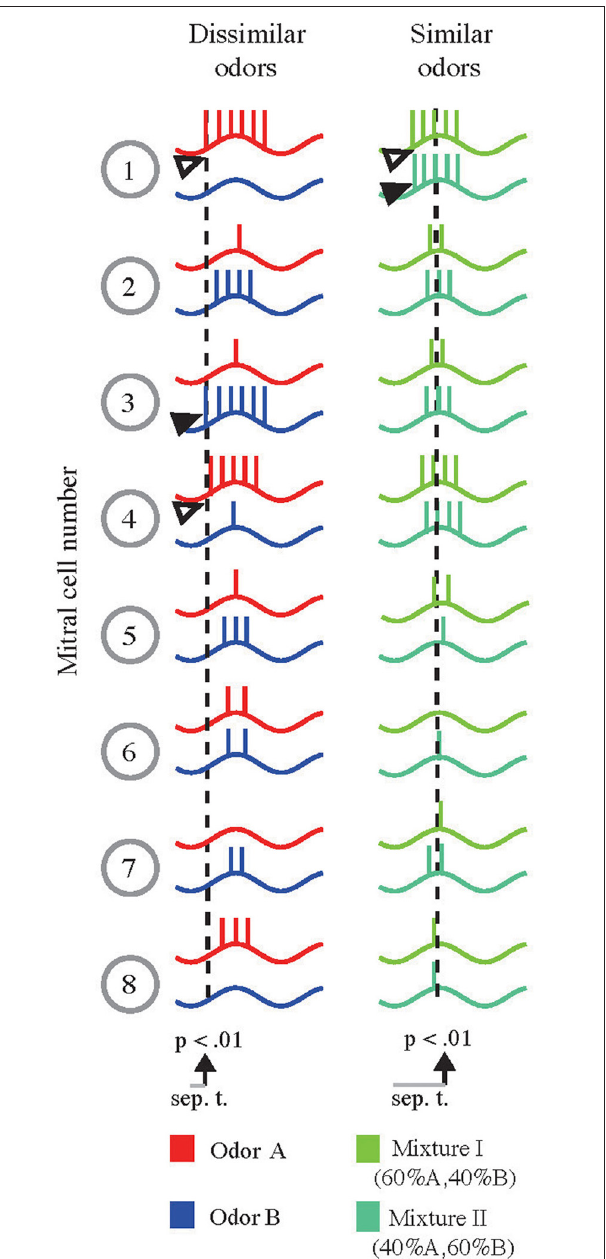
FIGURE 5 | Schematic representation of the proposed AP latency-based scheme and emerging similarity-dependent separation times. Left column : Sketch of the membrane potential of eight M/TCs in response to two different odors ( red and blue ) with little spatial overlap. For dissimilar odors arrows indicate M/TCs that respond either weakly for odor A and strongly for odor B ( solid arrow , M/TC #3) or vice versa ( open arrows , M/TC #1 and #4). Based on AP latencies in the strongly activated M/TCs reliable stimulus separation may be achieved early during the evoked response (indicated by the dotted line ). Right column : Same M/TCs in response to two similar odors (binary mixtures of A and B, Mixture I [60%A, 40%B], light green; Mixture II [40%A, 60%B], dark green). Due to the overall similarity of M/TC responses, information from many more cells (including those with delayed onsets e.g., M/TC #5 and #6) must be obtained to allow for stimulus separation ( dotted lines